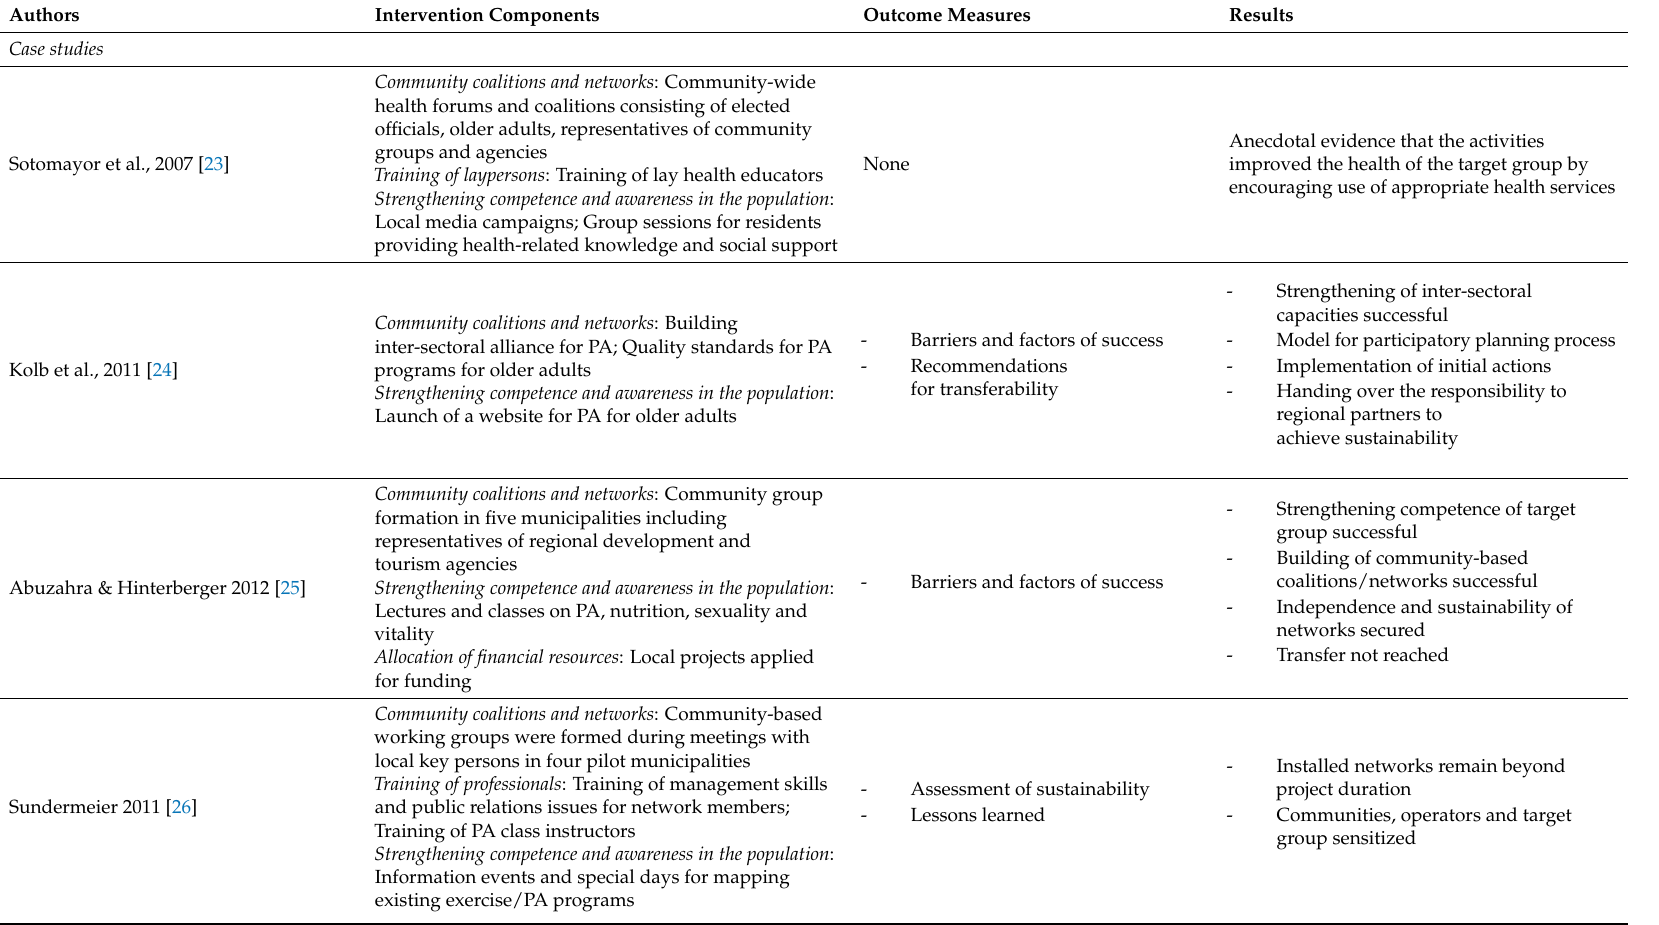
Table 2. Intervention components, outcome measures, and results of the included